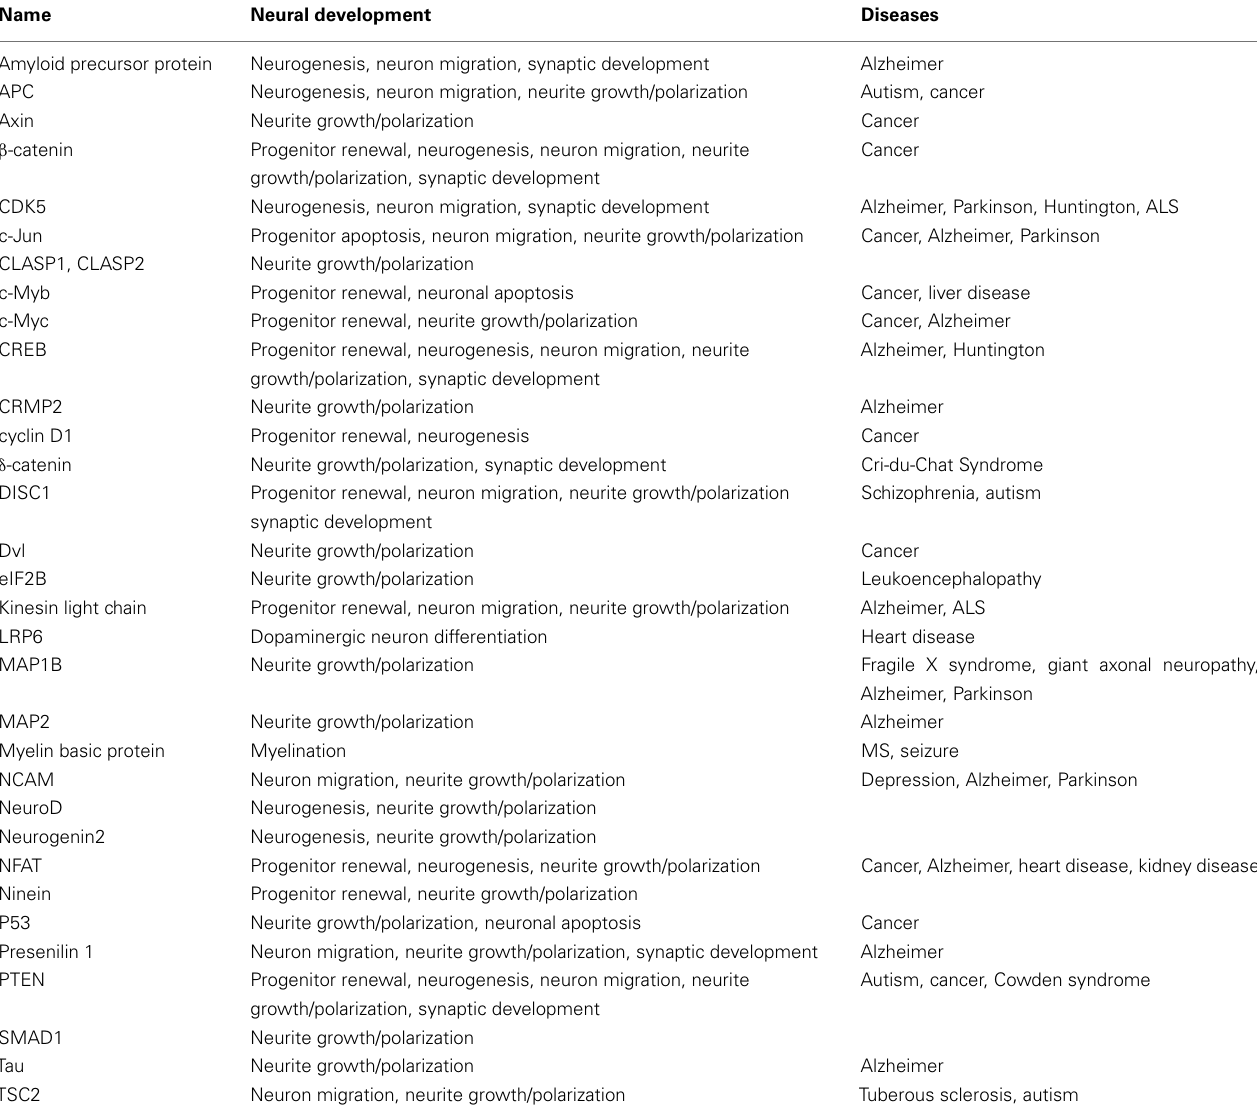
Table 1 | Glycogen synthase kinase-3-interacting proteins associated with neural development and